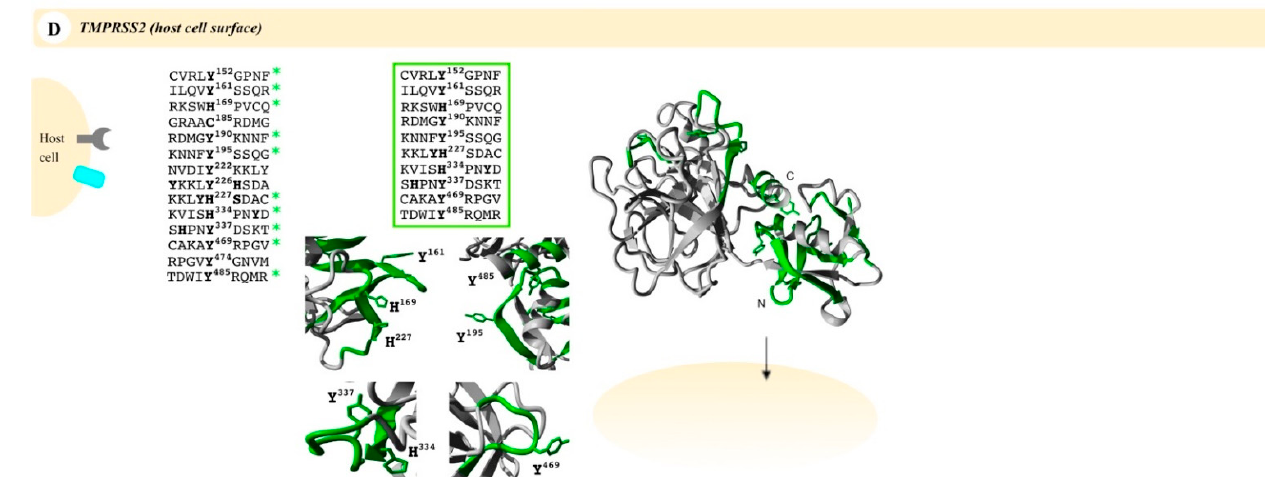
Figure 3. Potential heme-binding proteins on the virus and host cell’s surface. Four COVID-19-related proteins (first column, left), namely, the virus proteins (grey) S protein (red, panel ( A )) and protein 7a (orange, panel ( B )) as well as the host cell proteins (yellow) ACE2 (green, panel ( C )) and TMPRSS2 (turquoise, panel ( D )), represent potential heme-binding proteins. All motifs predicted by HeMoQuest [55] are shown excluding those with modifications (glycosylation, disulfide bonds) or located in intracellular or virion domains. A refined analysis considering the surface accessibility of the motifs resulted in the following number of motifs: 3 (S protein), 2 (protein 7a), 5 (ACE2), and 10 (TMPRSS2) (third column). The motifs are highlighted in a zoom-in below (green; third column) as well as in the available monomer (fourth column) and oligomer (fifth column) structures, if applicable (S protein, homology model from C-I-TASSER [76]; protein 7a, PDB: 6W37; ACE2, PDB: 6M18; TMPRSS2, Swiss-model: O15393). Within the oligomers, the motifs were only depicted in one of the monomers (green). Since some surface-exposed motifs in the S protein were not covered by the available EM structure (PDB: 6VXX), motifs were highlighted in the monomer (turquoise), which was then superimposed with the trimer (PDB: 6VXX). Blue: glycosylation sites and ions (if